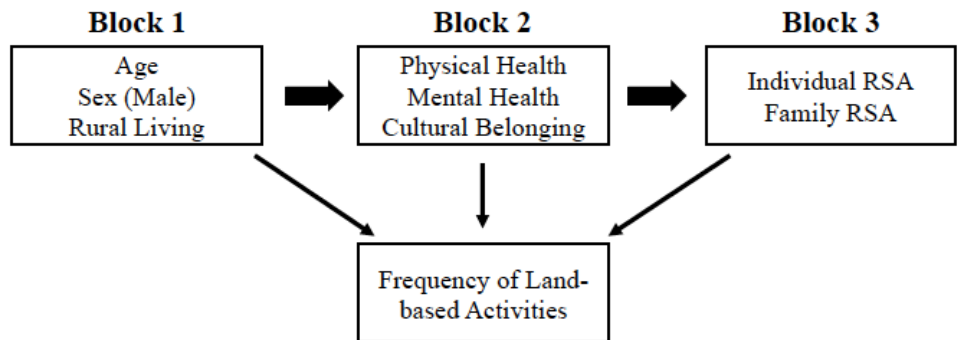
Figure 1. Predictors of engagement in land-based activities.